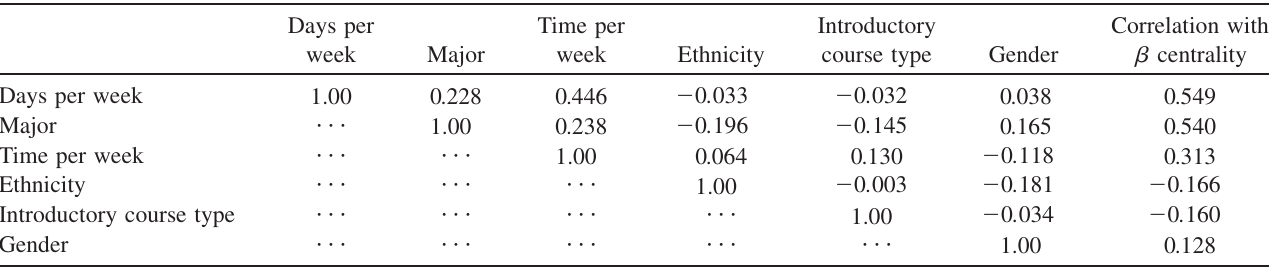
TABLE II. Correlation matrix of independent variables used in hierarchical multiple